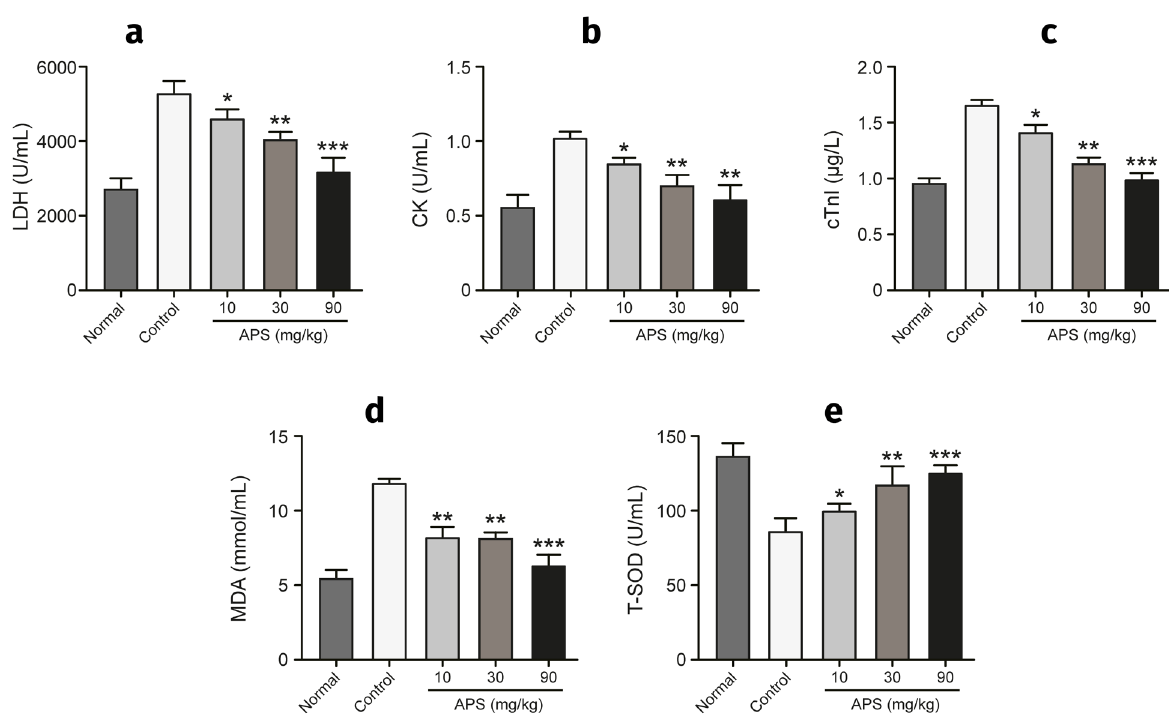
Figure 3. Efficacies of APS treatment on serum cardiac markers in overtraining rats. The concentration of (a) LDH, (b) CK, (c) cTnI, (d) MDA and (e) T-SOD in rat serum. * = p < 0.05, ** = p < 0.02, *** = p < 0.001 vs. saline-treated excessive exercise rat group. Values represent mean ± SD of 8 independent